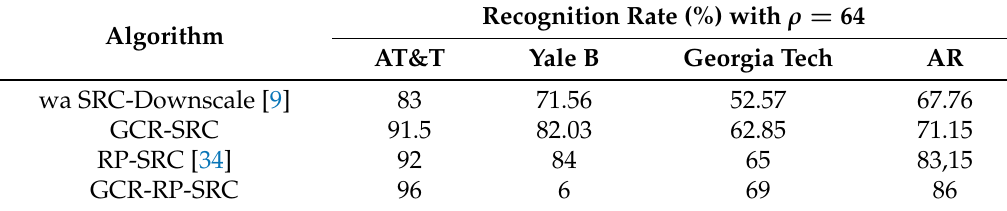
Table 2. Recognition Rate Simulation Result.